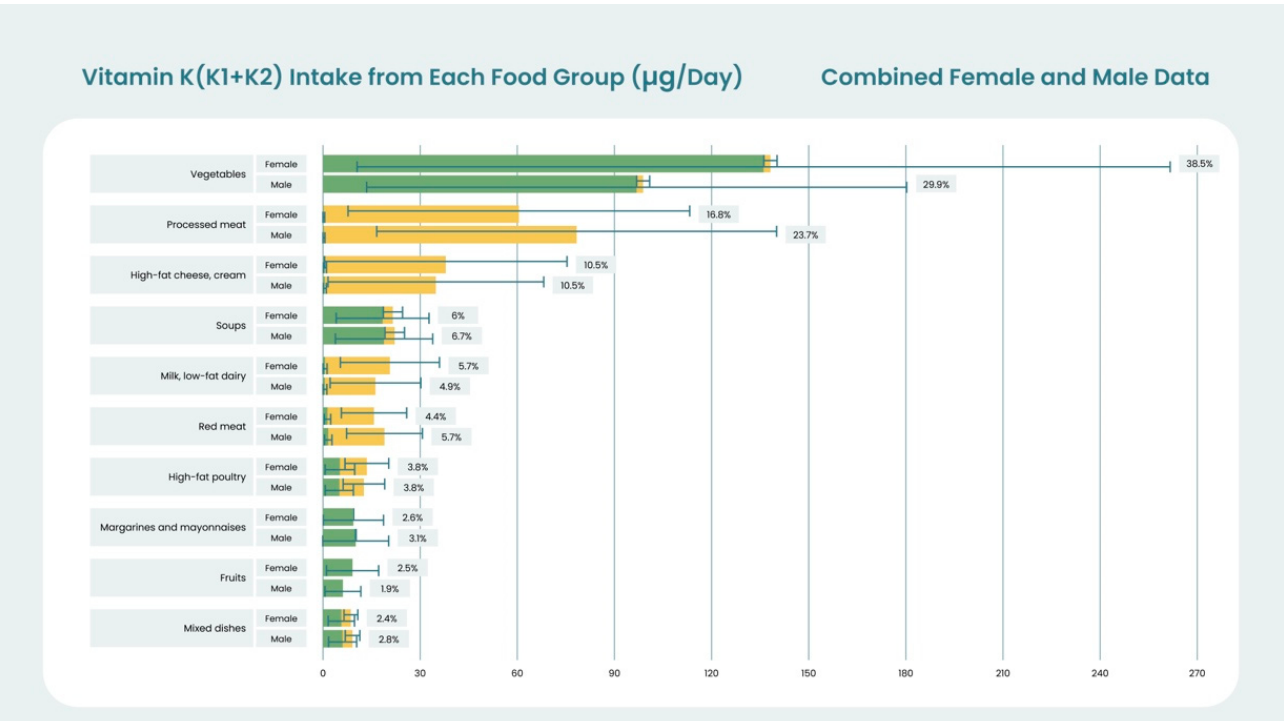
Figure 1. Combined female and male VK mean (µg/day) and SD daily intake in 1985 Polish adults aged 35-70 years, enrolled in the Polish arm of the global, epidemiological, cohort-based Prospective Urban Rural Epidemiology study (PURE) from 2007 to 2009. Values represent the top 10 of 25 food groups contributing 93% of the total VK dietary intake in both female and male subjects. Scale is 0–270 (µg/day), error bars represent SD for each food group by sex. Percent (%) values represent the percentage of total daily intake of VK by food group and sex. Green color represents PK, yellow represents Mk-n. Data presented to visualize source and relative PK and Mk-n content in contem- porary diet contrasted by sex. Adapted from [52]. (CC BY license h tt ps://creativecommons.org/li- censes/by/4.0/).